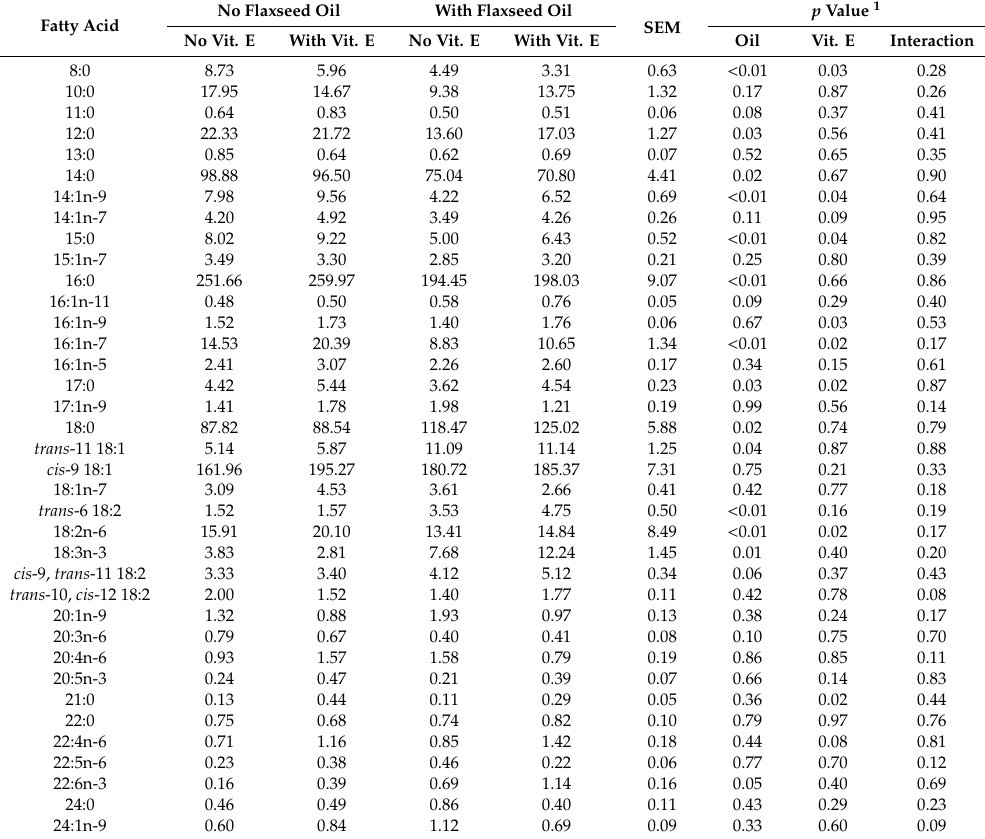
Table 4. Milk fatty acid composition (mg / g total FA) of lactating bu ff aloes fed diets containing flaxseed oil and / or vitamin E.